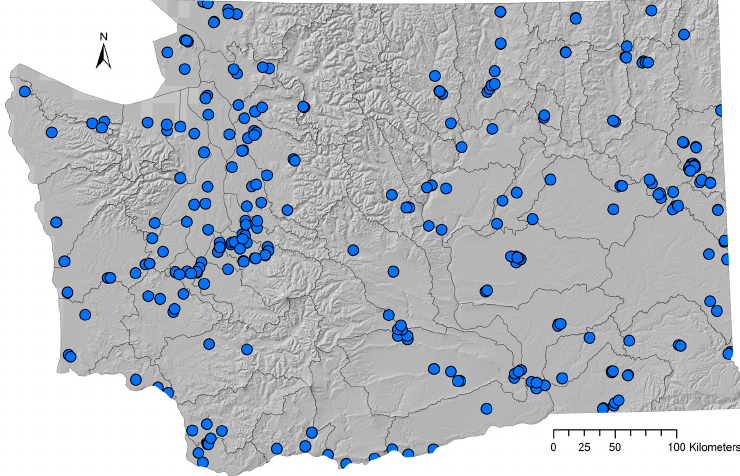
Figure 5. Location of 284 water wells evaluated for ASR suitability.